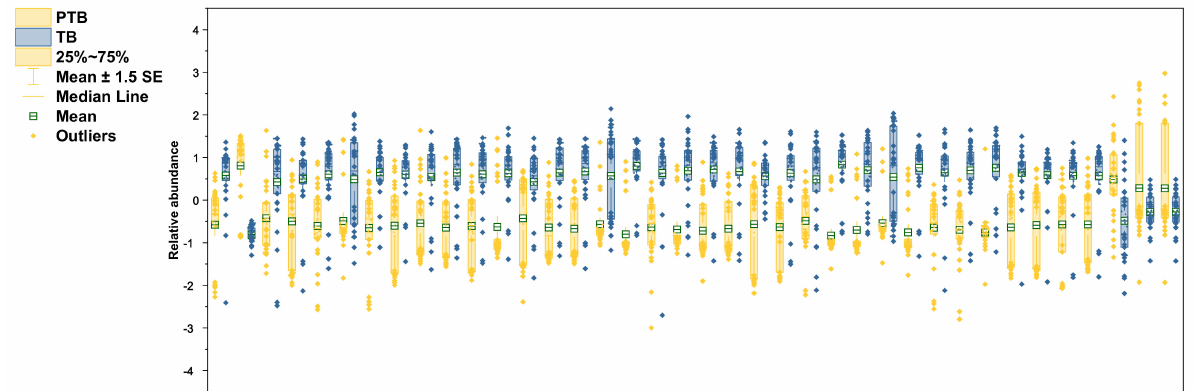
Figure 6. Relative abundance of altered lipidomes in CVF. Yellow color in boxplots indicates PTB groups and blue color indicates TB groups. Boxplots contain the range of 25–75%, median line, mean with S.E.M, and